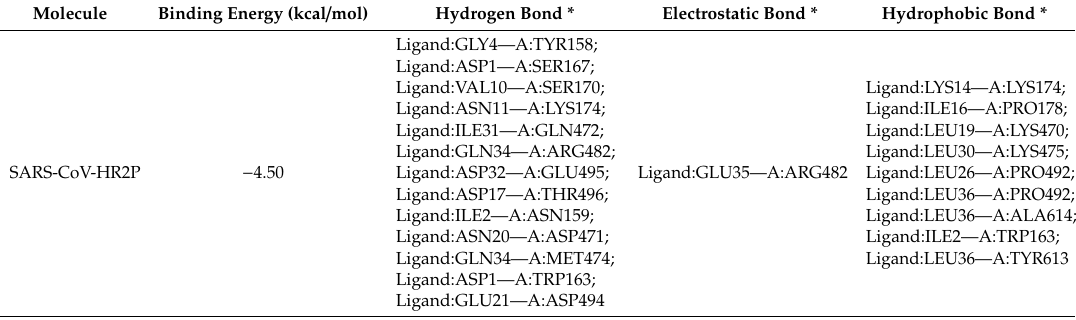
Table 6. Comparison of binding energy and interactions between control peptides and caerins to the ACE 2 protein. Molecule Binding Energy (kcal / mol) Hydrogen Bond * Electrostatic Bond * Hydrophobic Bond *